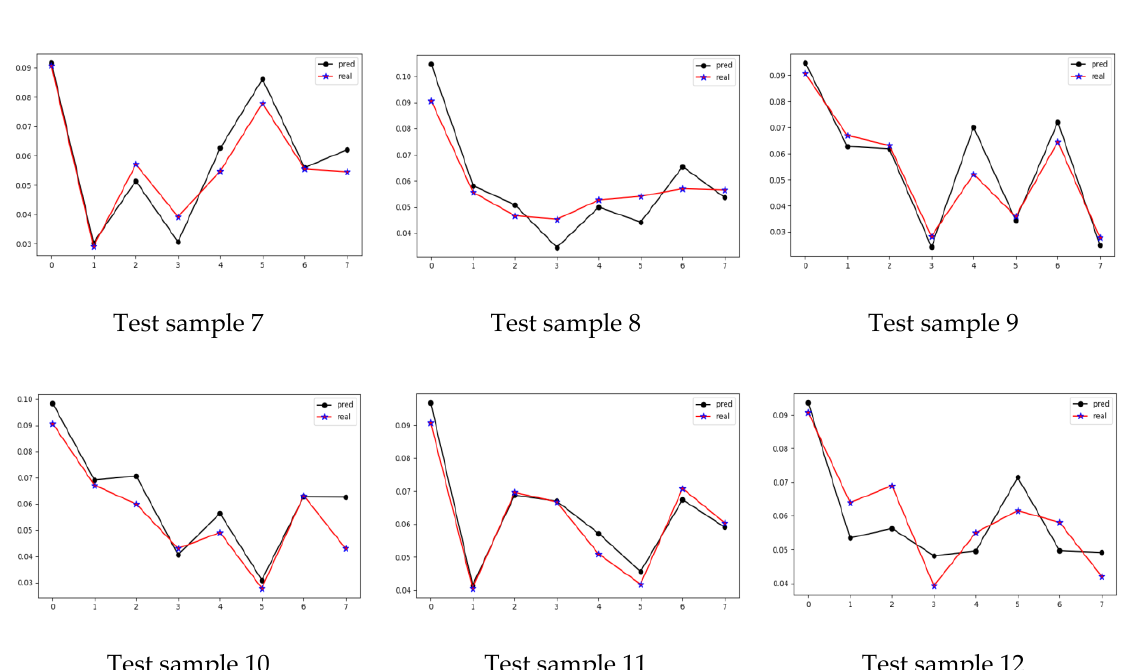
Table 4. Comparison of the predicted and true values of the 4 groups.